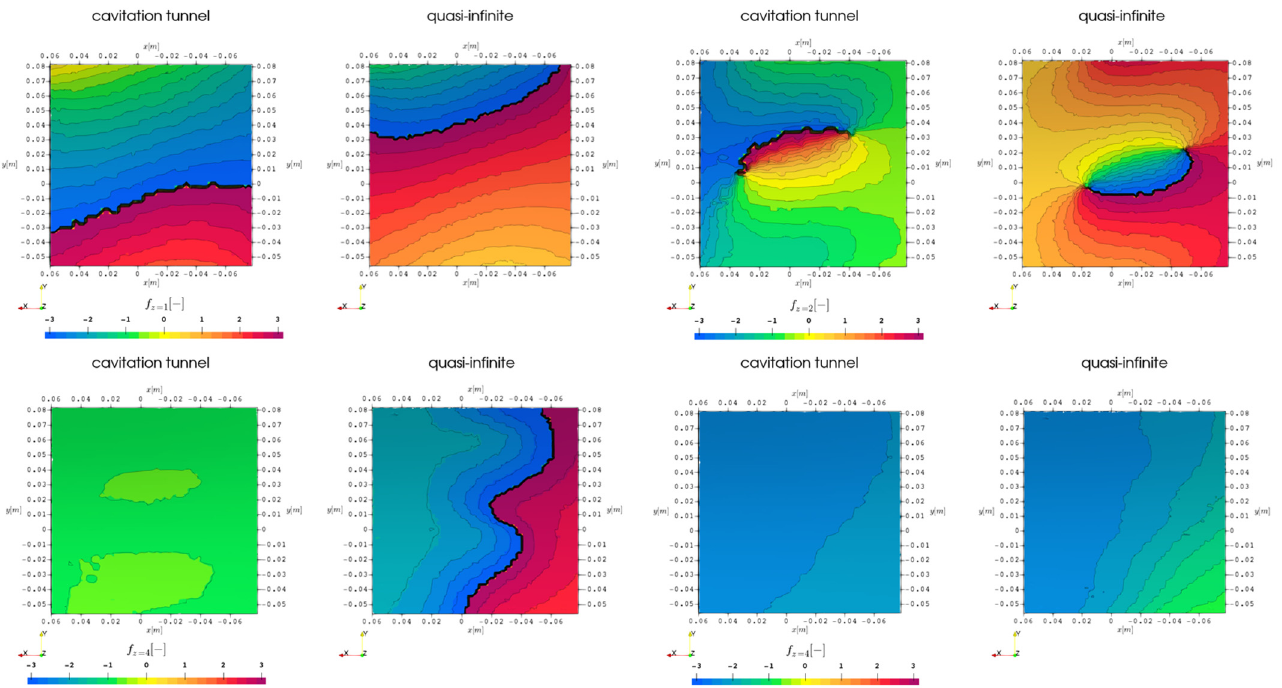
Figure 7. Phase information on hull at the first 4 harmonic propeller blade harmonic frequencies, comparison of domain extent, and RANS.